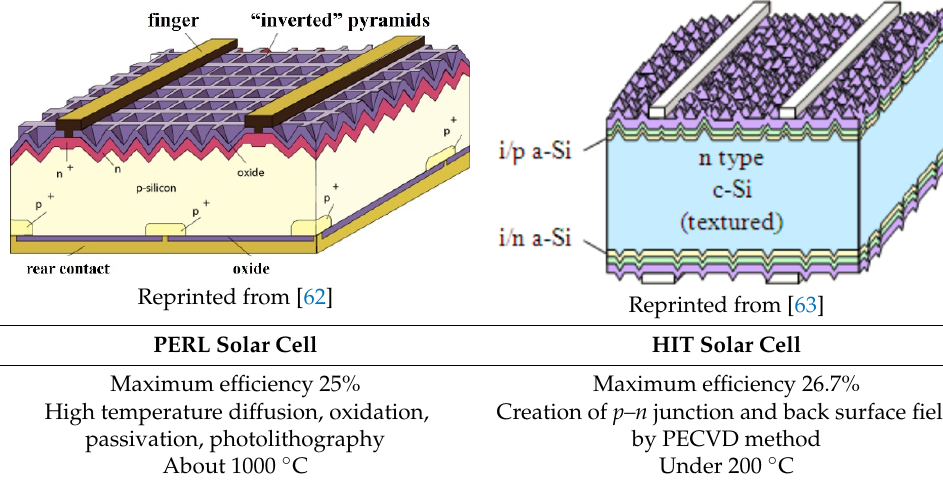
Table 2. Comparison of PERL solar cells with heterojunction elements (based on [60,61]).